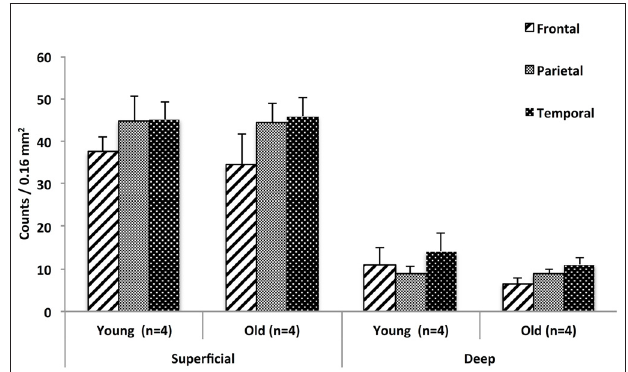
FIGURE 4 | Regional distribution of WMNs in frontal (FR), parietal (Par), and temporal (TE) in young (n = 4) and old monkeys (n = 4) . No significant difference was observed in the density of WMNs in the three regions, nor between the age groups.